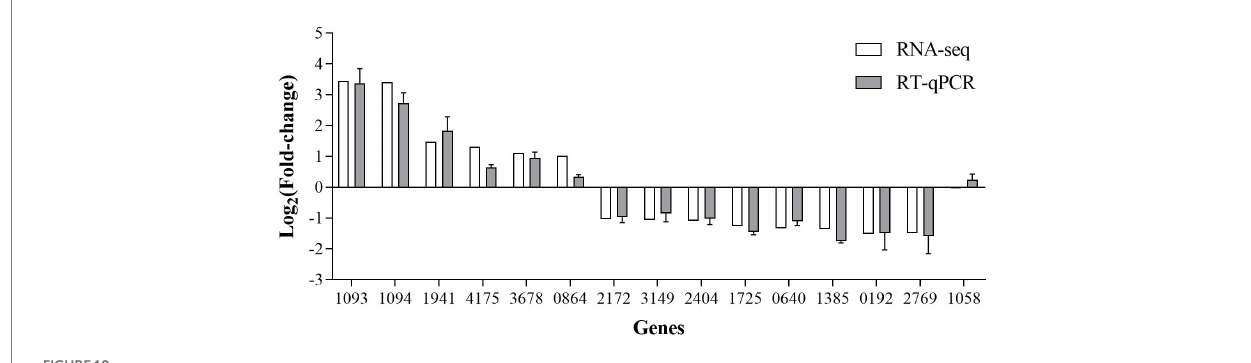
FIGURE 10 RT-qPCR verification of the SDE genes produced by RNA-seq.